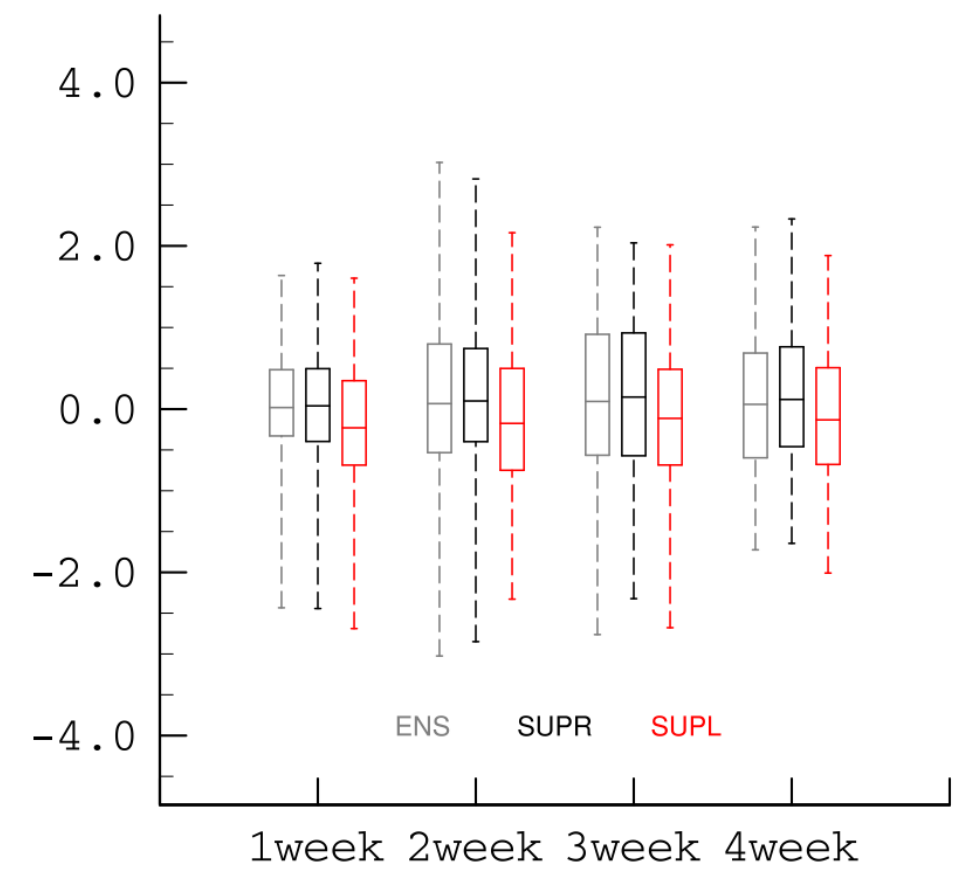
Figure 5. Box-and-whisker plot of MBE at the 1–4 weeks, derived from the ensemble forecast of ENS (grey), SUPR (black), and SUPL (red). The bounds of the box are at the 25th and 75th percentile, and the flat line in the box is the median. The whiskers represent the minimum and maximum values.